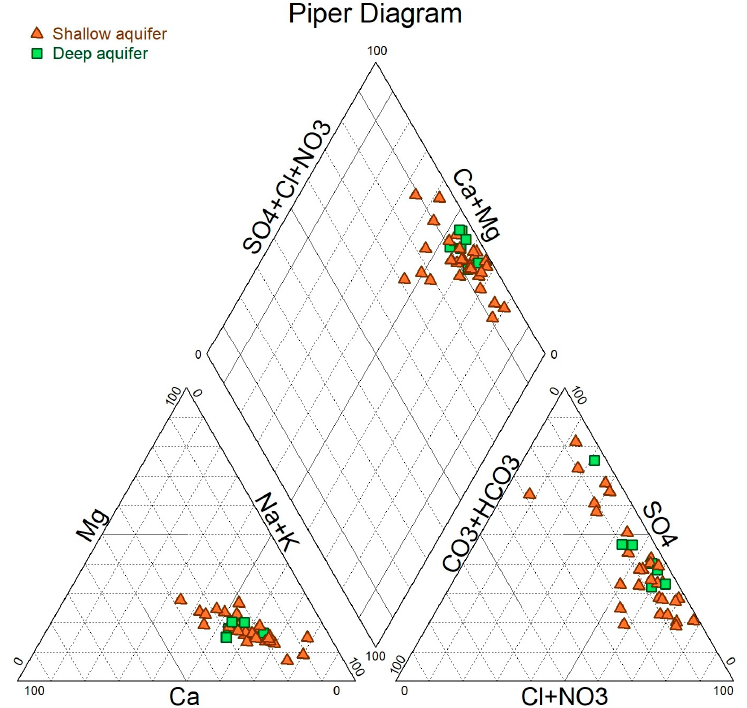
Figure 6. Piper diagram drawn for shallow and deep aquifer.